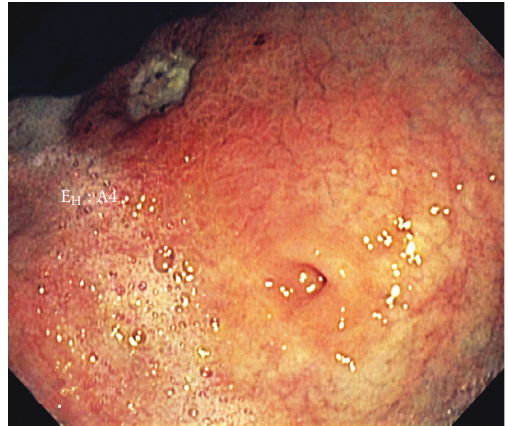
Figure 1: Endoscopic gastroduodenoscope showing gastric outlet obstruction with a very small opening in the antrum.